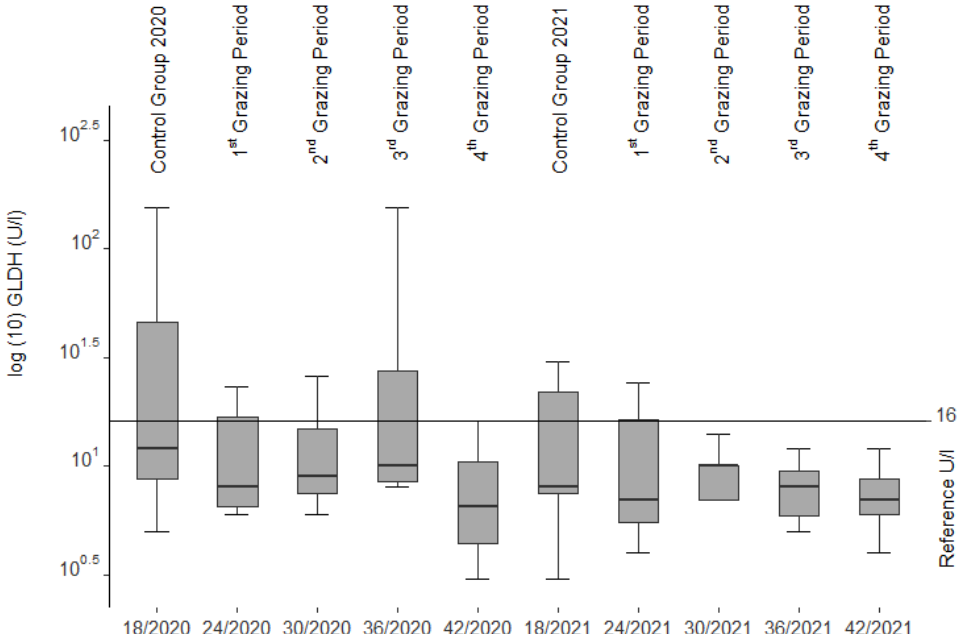
Figure 3. Glutamate dehydrogenase (GLDH) activities from blood serum of the slaughtered sheep.